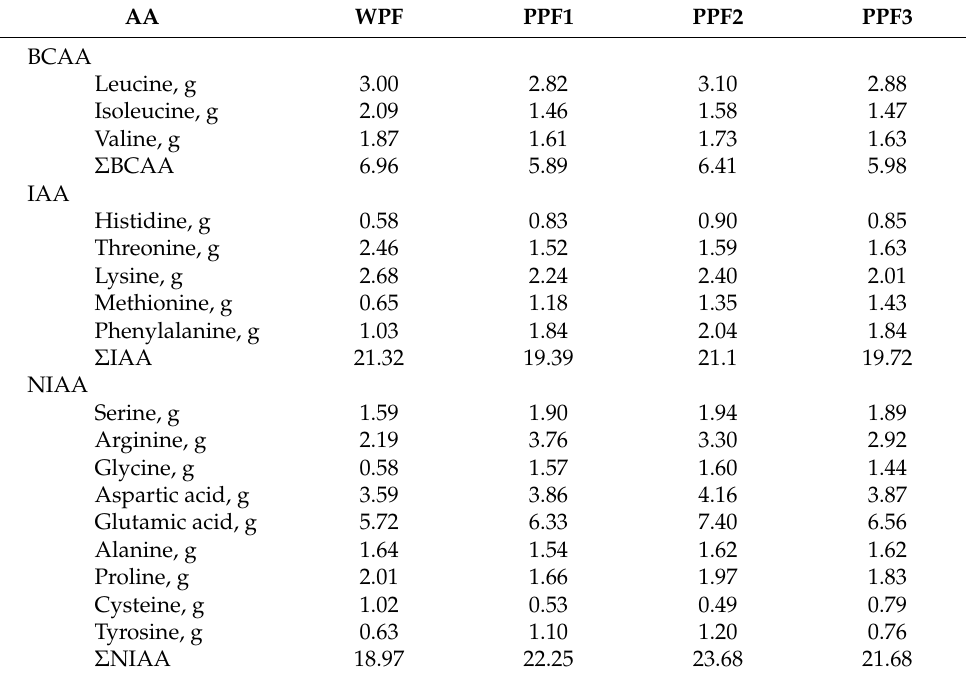
Table 3. Protein products AA composition (quantitatively measured) 1